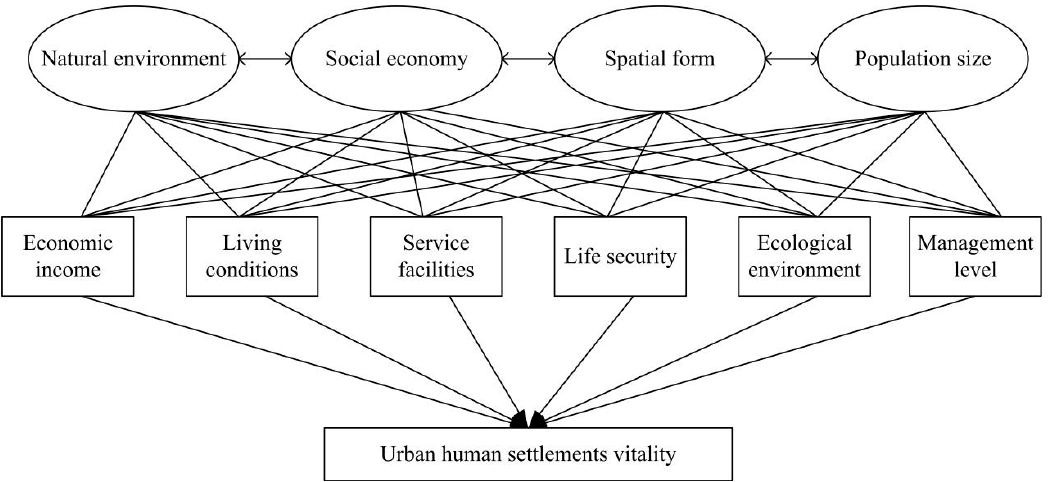
Figure 6. Mechanism of influencing factors of urban human settlements vitality.